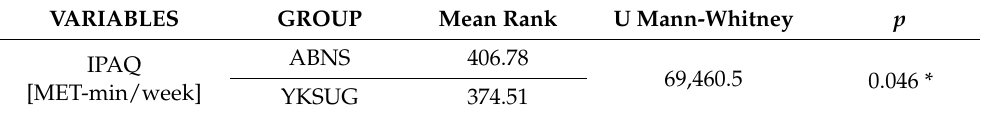
Table 5. Differences in test results between groups ABNS and YKSUG-non-parametric test. VARIABLES GROUP Mean Rank U Mann-Whitney IPAQ